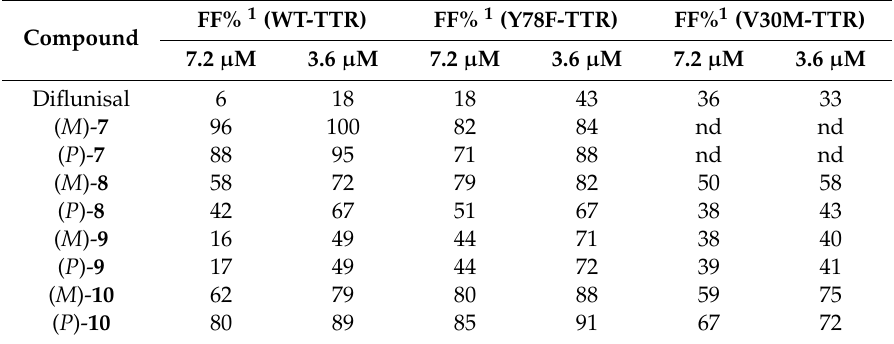
Table 2. Inhibition of WT-, Y78F-, and V30M-TTR amyloid fibril formation under acidic denaturation condition in the presence of diflunisal, and pure enantiomers of derivatives 7 – 10